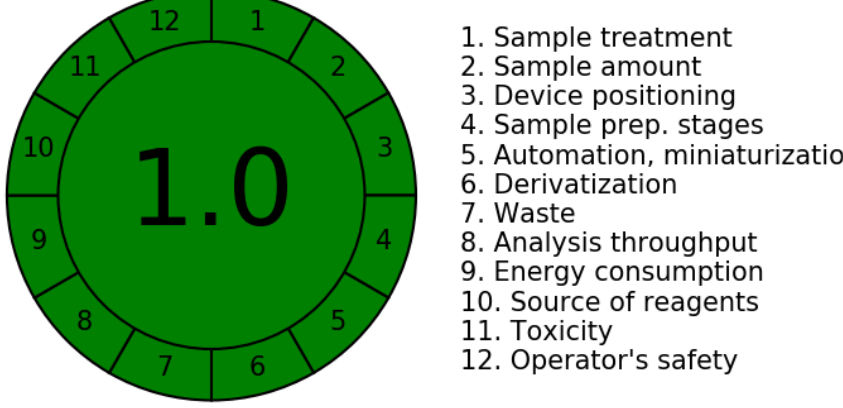
Figure 1. Greenness evaluation criteria as suggested by the AGREE method. To allow proper comparison, the weights for the 12 evaluation criteria were reset, where the default weight given for all was two according to the instructions for use. However, we changed the weights for criteria number 7 (waste), number 8 (analysis thruput/number of analytes per run), number 11 (toxicity) and number 12 (operator’s safety), where all criteria were set to have a weight of four due to their importance and ability to differentiate chromatographic methods (Figure